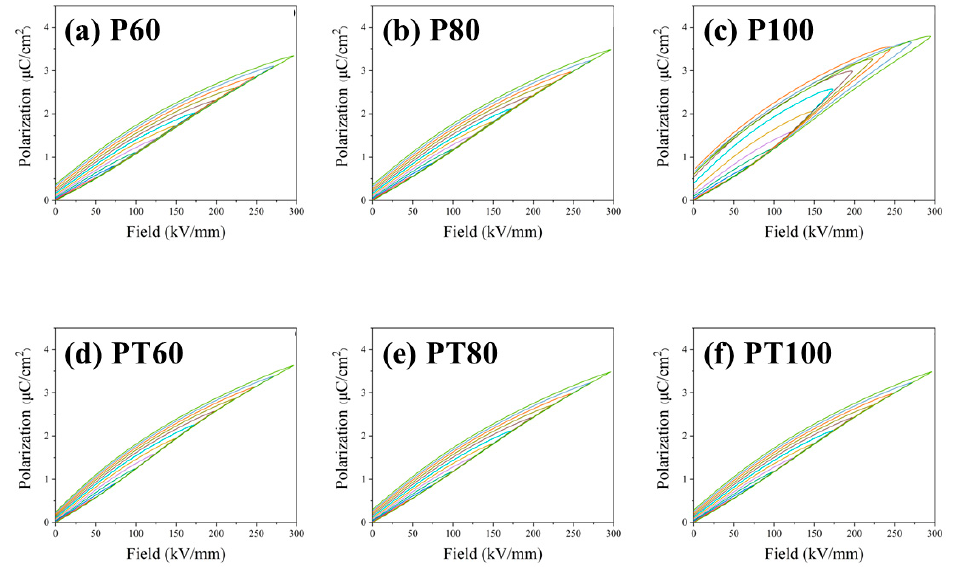
Figure 3. P–E loop of PVDF and its composite, ( a – c ) are the hysteresis loops of pure PVDF at 60, 80 °C, 100 °C, and ( d – f ) are the hysteresis loops of PTFE–c–PVDF at 60 °C, 80 °C, 100 °C.